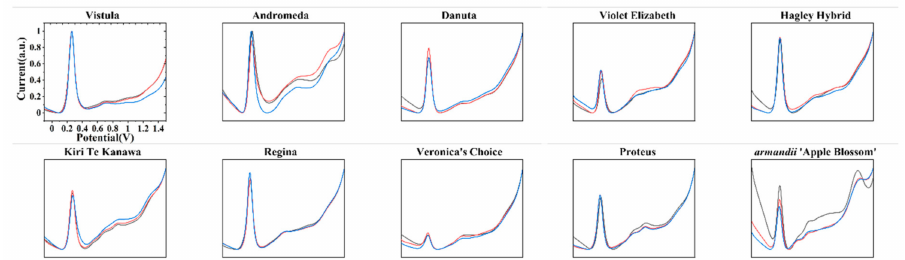
Figure 2. Di ff erential pulse voltammetry (DPV) curves of Vistula, Andromeda, Danuta, Armandii ‘Apple Blossom,’ Proteus, Hagley Hybrid, Violet Elizabeth, Kiri Te Kanawa, Regina, and Veronica’s Choice recorded in a 0.1 M phosphate bu ff er (PBS) after water extraction.